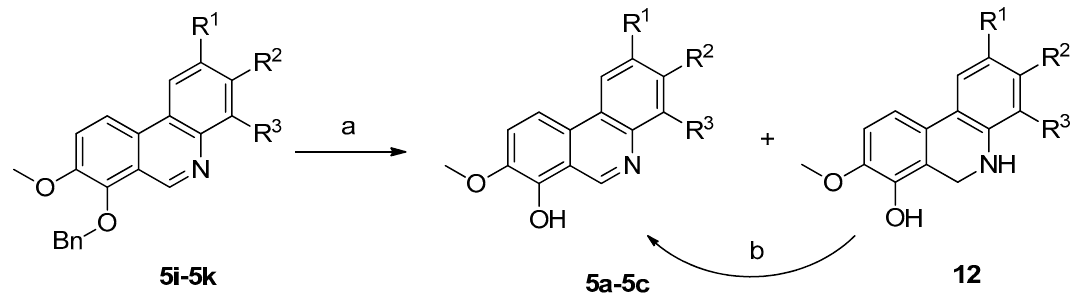
Table 2. Antibacterial